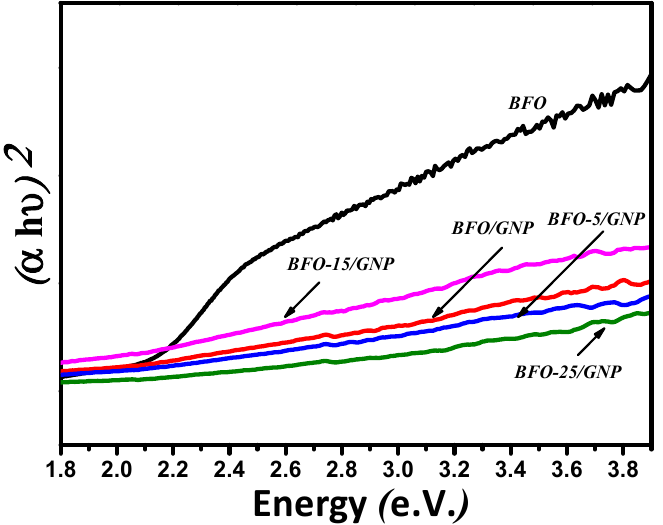
Figure 6. The tauc’s plot of BGFSO / GNP nanohybrids representing curves for band-gap measurement.